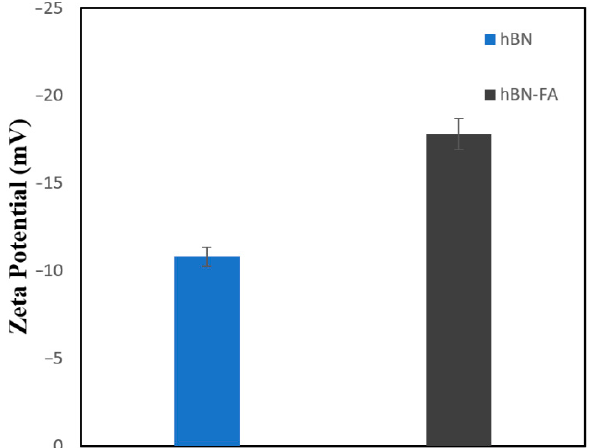
Figure 5. Zeta potentials of hBN and the hBN-FA complex.